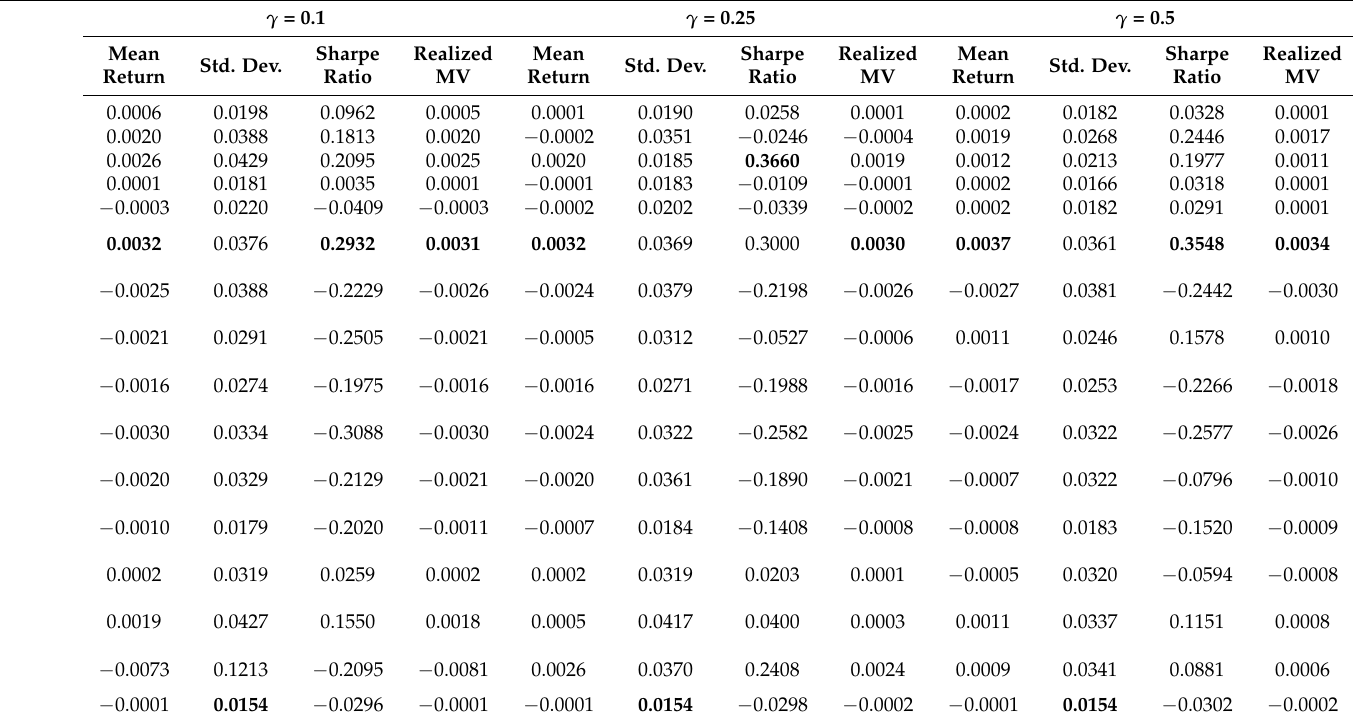
Table 7. Realized portfolio performance of mean-variance strategies based on HMM vs. stepwise regression forecasts (no transaction costs). The table reports a range of realized OOS performance measures obtained from recursive mean-variance portfolio optimization strategies over a January 2004–May 2018 sample. The 16 models reported are obtained as three HMMs with regimes plus the best 12 stepwise predictive regressions selected on the basis of their RMSFE, and the AR(1) benchmark. We boldface the highest realized